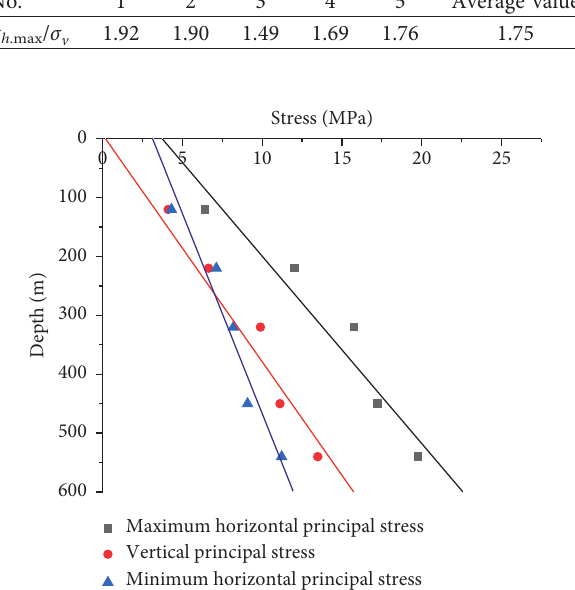
Figure 8: Regression curve of σ buried